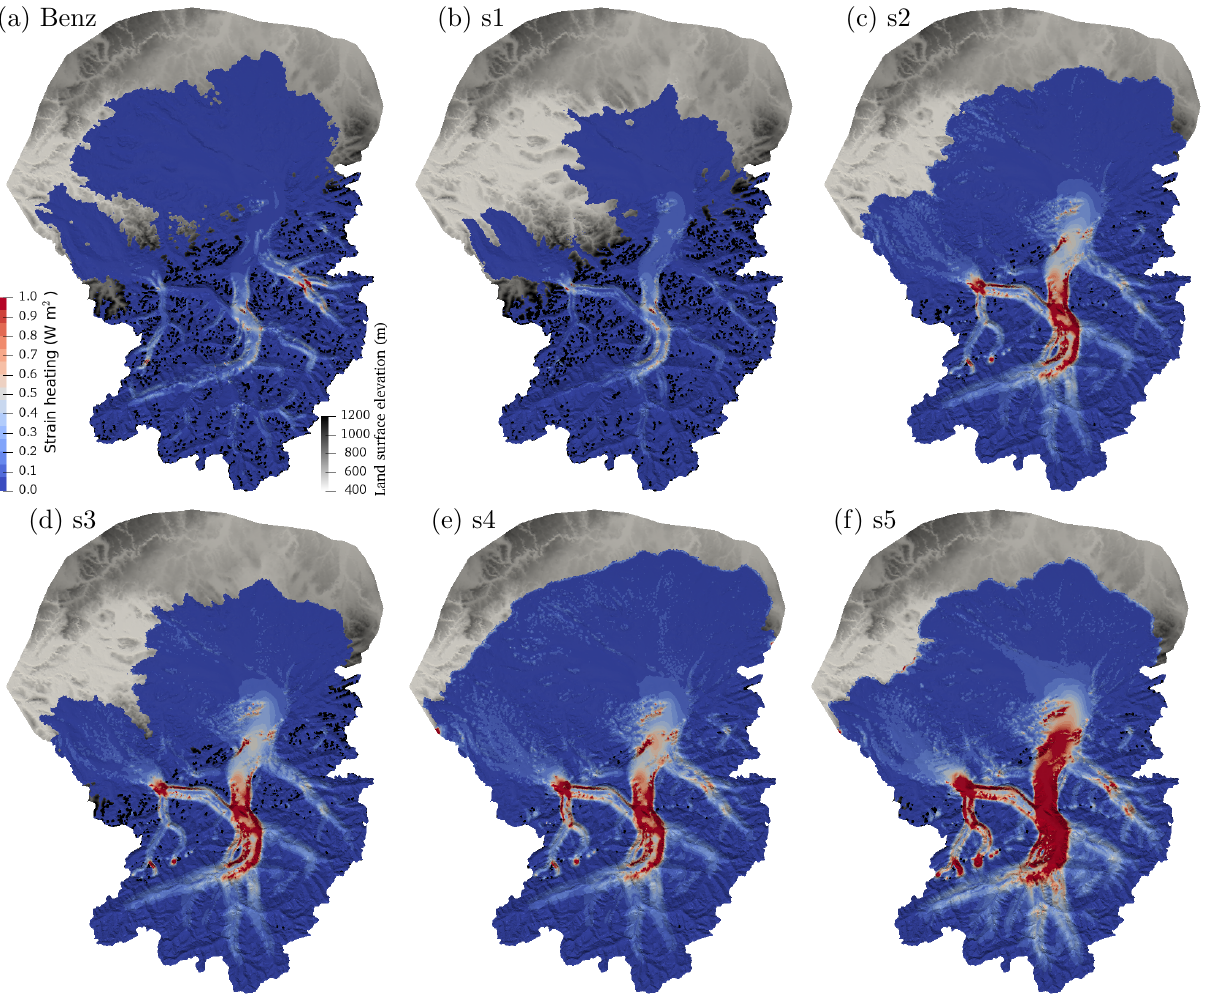
Figure 15. Vertically integrated strain heating in watts per square meter for (a) Benz-Meier (2003) after 50 years of free surface evolution and and (b–f) simulations